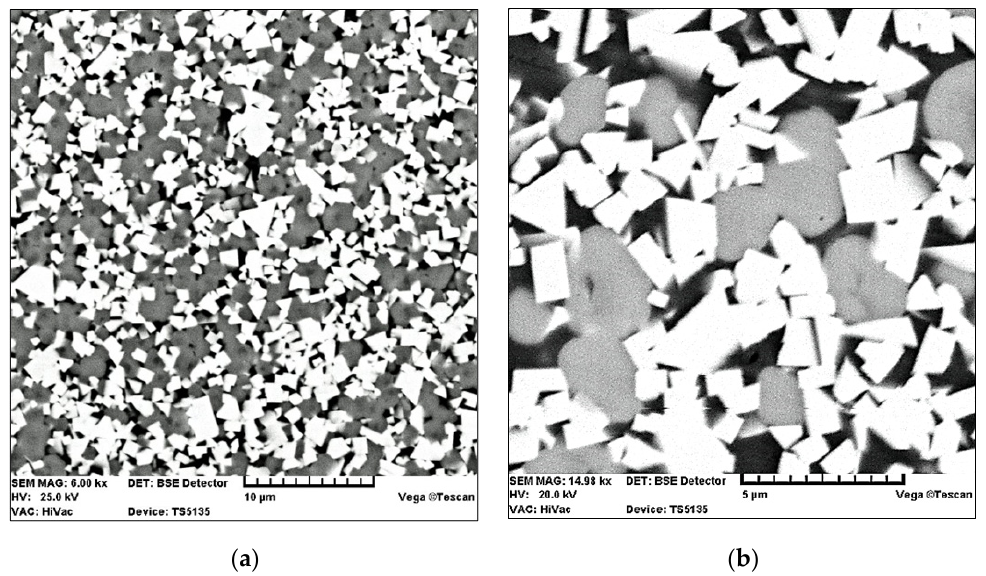
Figure 1. SEM images of the SM25 sintered carbide microsections at different magnification: ( a ) 6000×; ( b ) 15,000× [6,10].